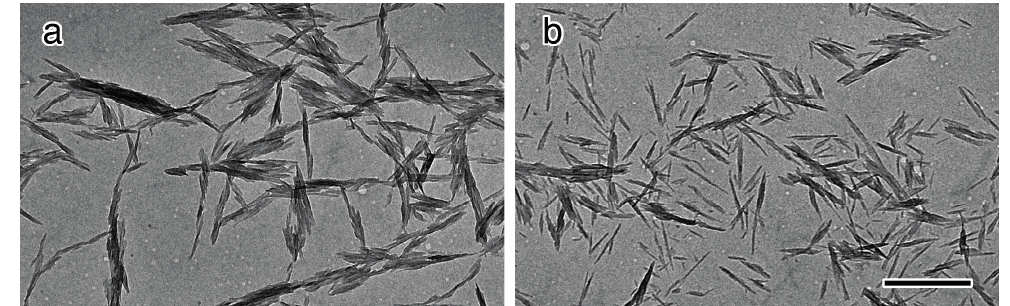
Figure 4. Electron micrographs of ( a ) ungrafted material and ( b ) 1k-DMAc-100c-7d. The scale bar is 500